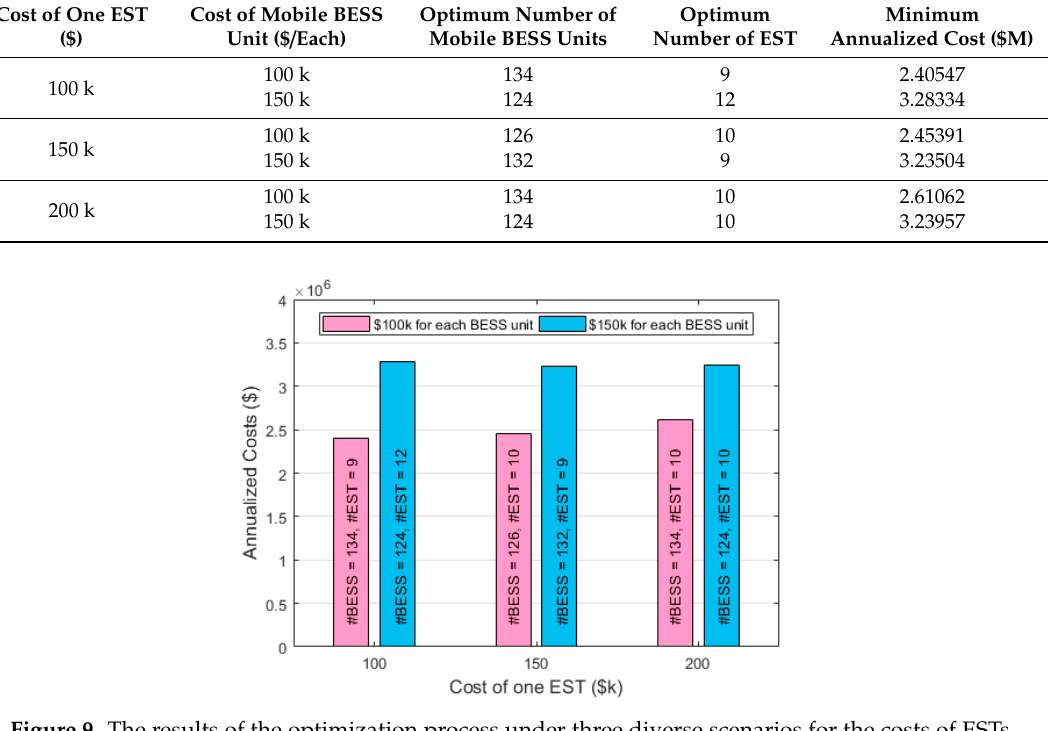
Figure 9. The results of the optimization process under three diverse scenarios for the costs of ESTs and two cases for the cost of mobile BESS units. In this study, the economic discount rate is 5% while the project’s lifetime is 25 years.